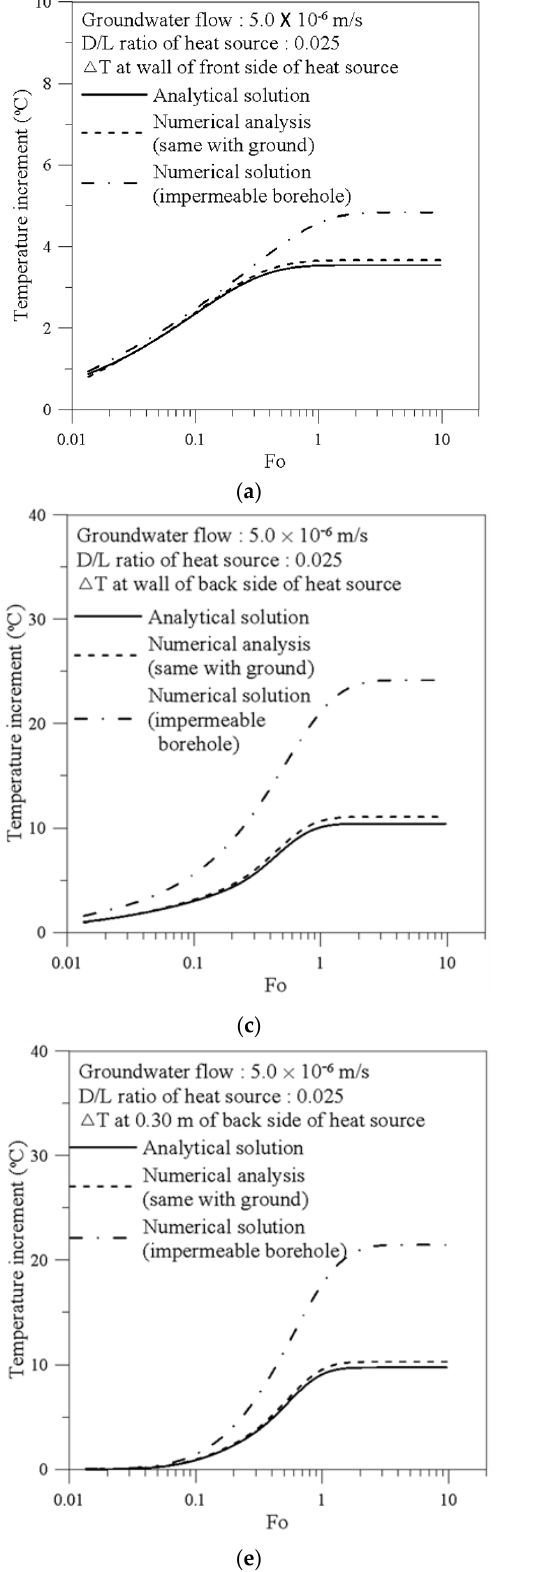
Figure 13. Comparison of analytical solution and numerical analysis results (u = 5.0 × 10 −6 m/s, D/L ratio = 0.025). Temperature increment at ( a ) wall of front side; ( b ) 0.15 m of front side; ( c ) wall of back side; ( d ) 0.15 m of back side; ( e ) 0.30 m of back side; ( f ) 0.50 m of back side.